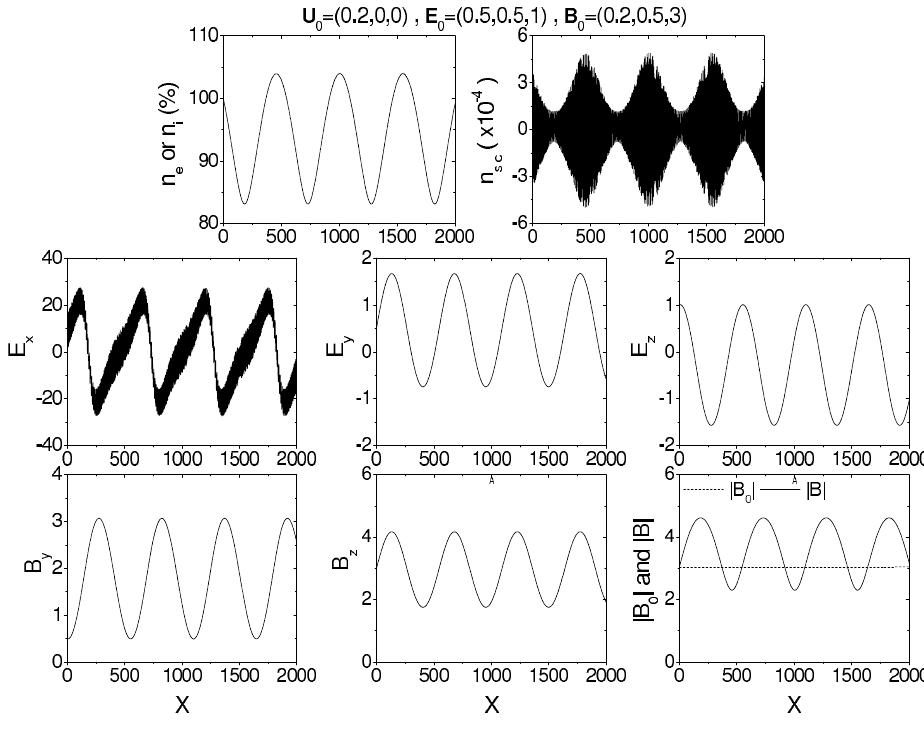
Fig. 7. Same as Fig. 4 but deformed sawtooth IA/IC solitary structures.